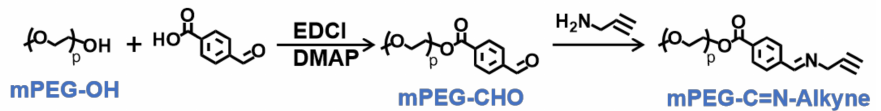
8.15 ppm (dd, - Ar -) and 8.90 ppm (-C H =N-CH 2 -), verified the successful syntheses of mPEG-CHO and mPEG-C=N-Alkyne.